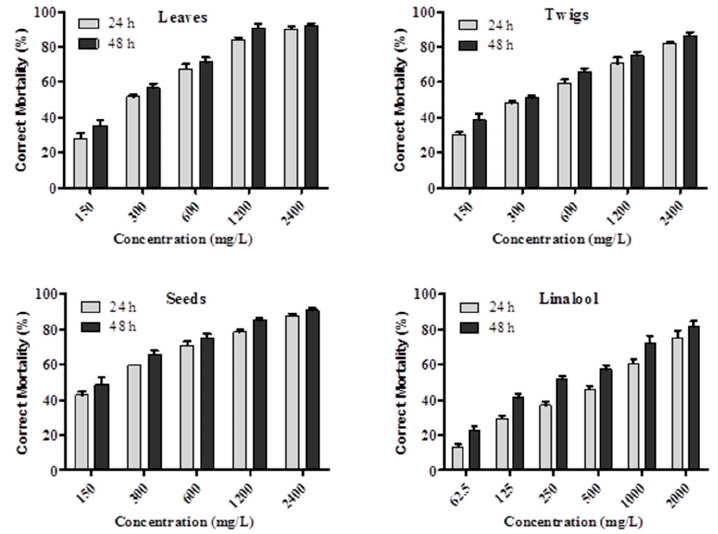
Figure 1. Contact toxicity of C. camphora essential oils and linalool on cotton aphids at different concentrations after 24 h and 48 h of treatment. Error bar represents the standard deviation of the mean ( n = 3).